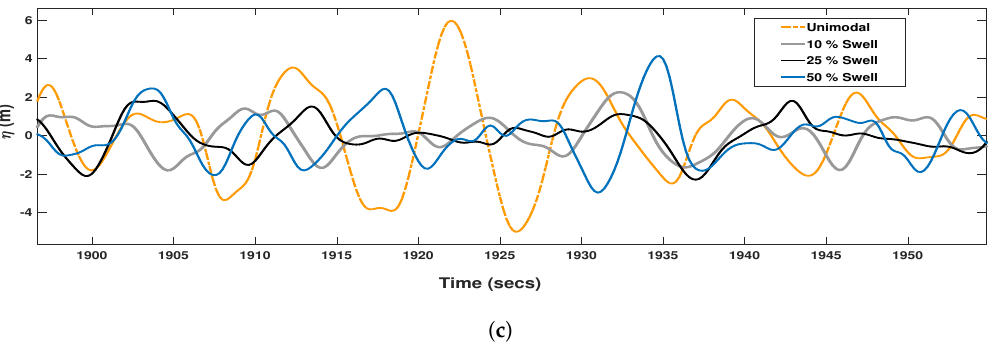
Figure 3. An example of the development of energy-conserved bimodal spectrum. ( a ) Tested bimodal spectrum; ( b ) An energy-conserved bimodal showing different frequencies of swell; ( c ) Sample surface elevation obtained by Inverse Fast Fourier Transform